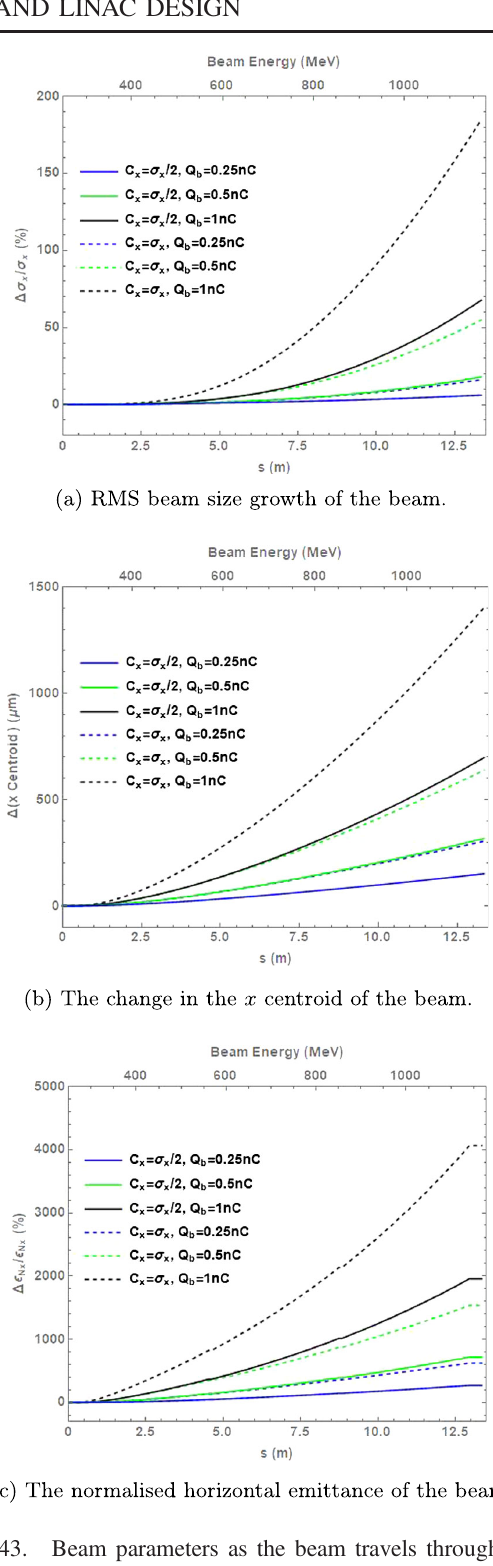
FIG. 43. Beam parameters as the beam travels through 24 rf 0 . 25 , 0.5 and 1 nC and beam structures for beam charges Q b ¼ σ = 2 and σ offsets C . Note that there are 0.4 m of drift space x ¼ x x before and after the linac with drift spaces of 2 cell widths between structures and 10 cm between modules. The beam energy is also shown on the top horizontal axis assuming an average structure gradient of h G i ¼ 80 MV =